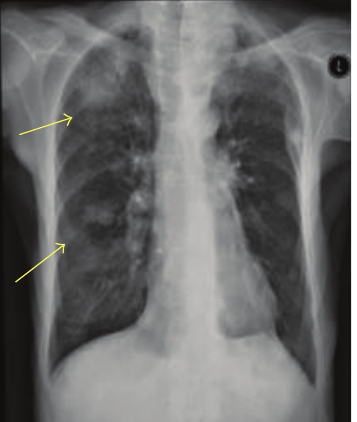
Figure 2: Chest radiograph showing multiple lung metastases.